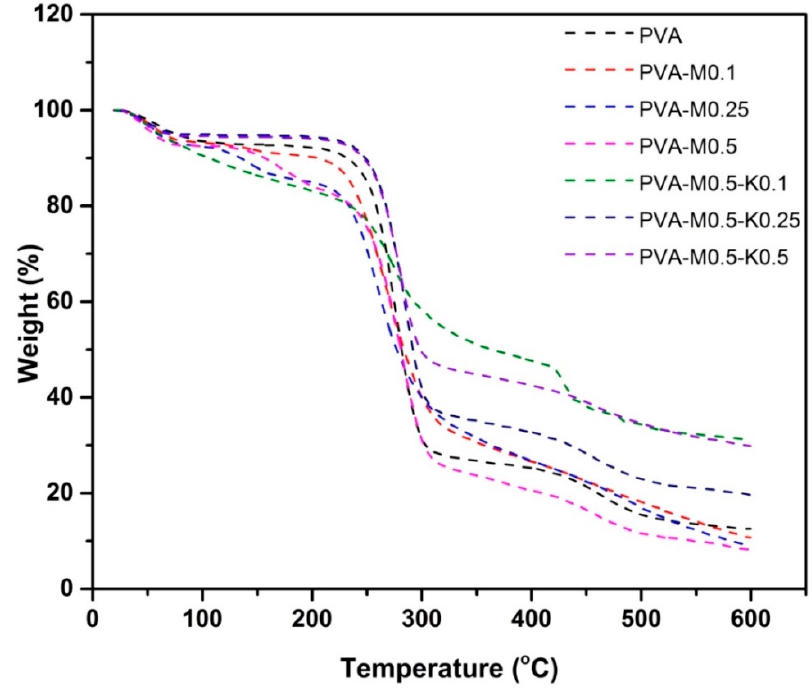
Figure 5. TGA charts of PVA, PVA/marjoram, and PVA/marjoram/kaolin composite sponges.